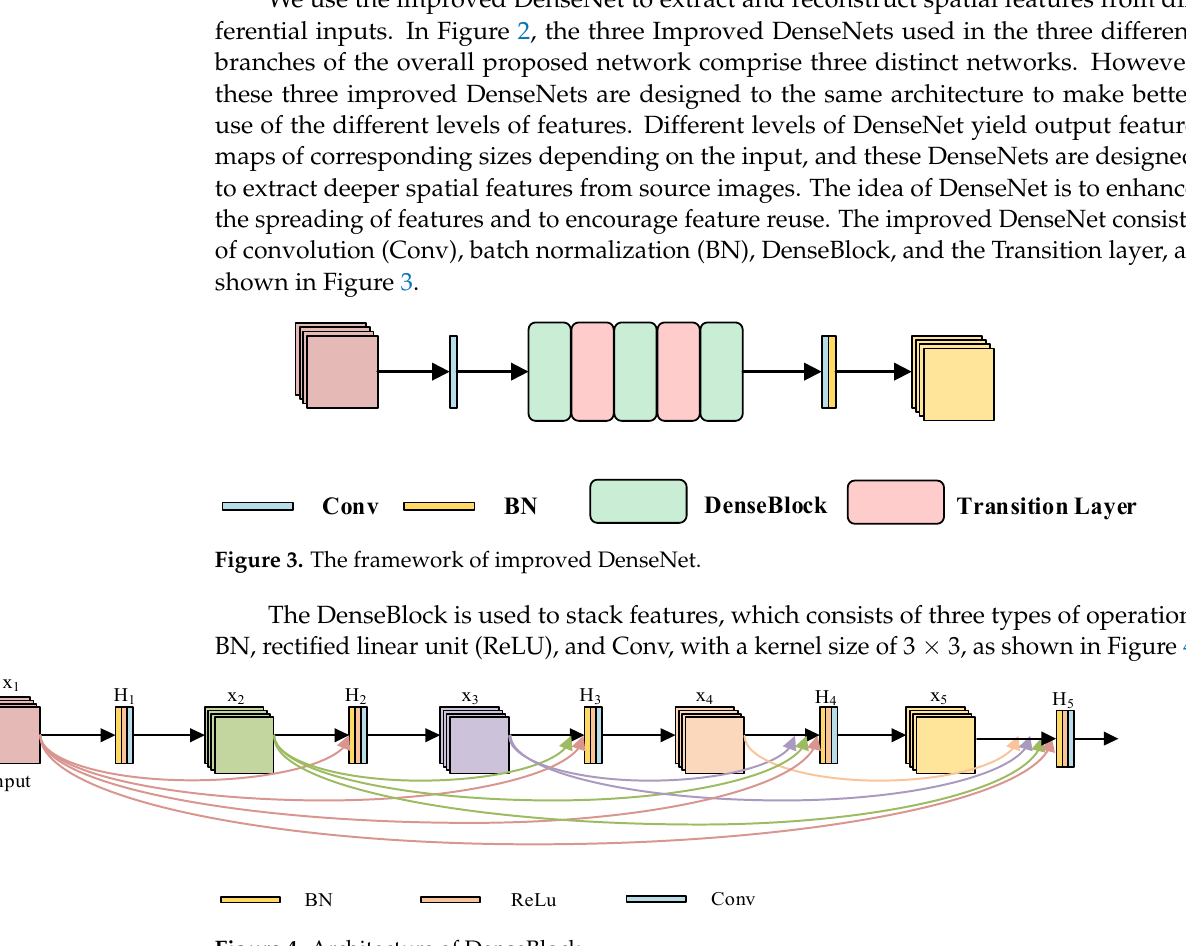
Figure 4. Architecture of DenseBlock.